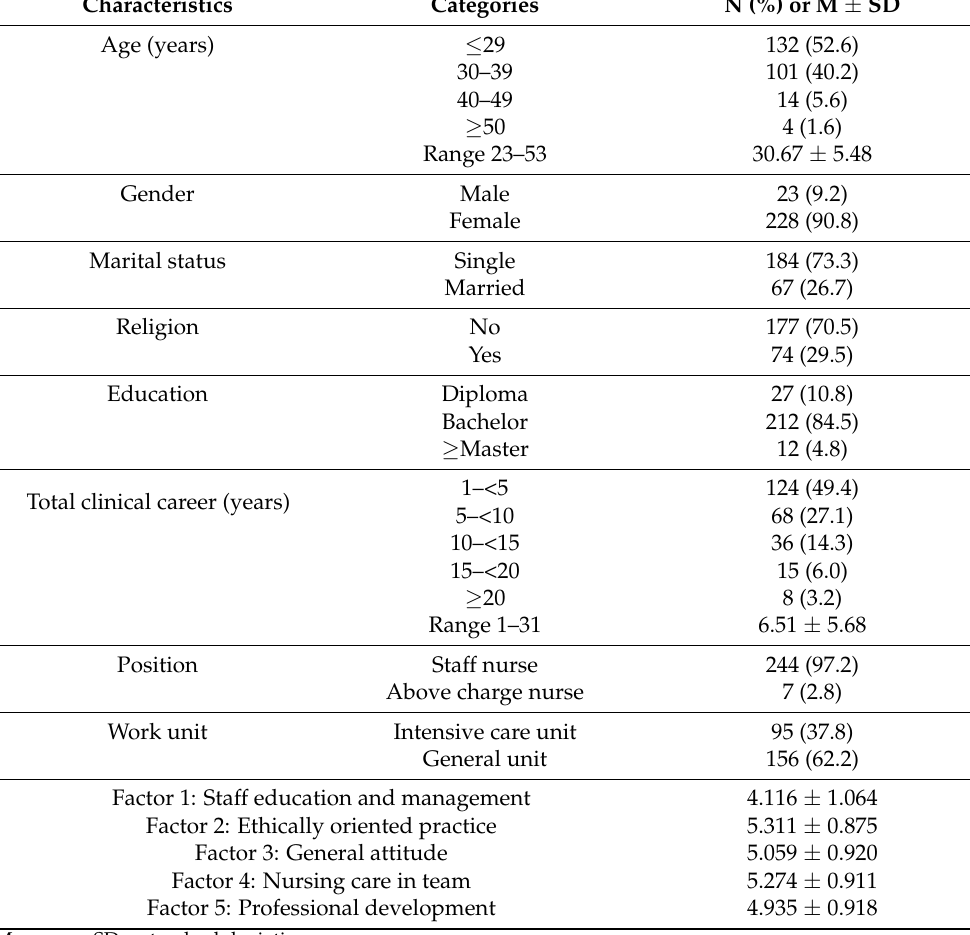
Table 1. General characteristics of participants and score according to factor (N =